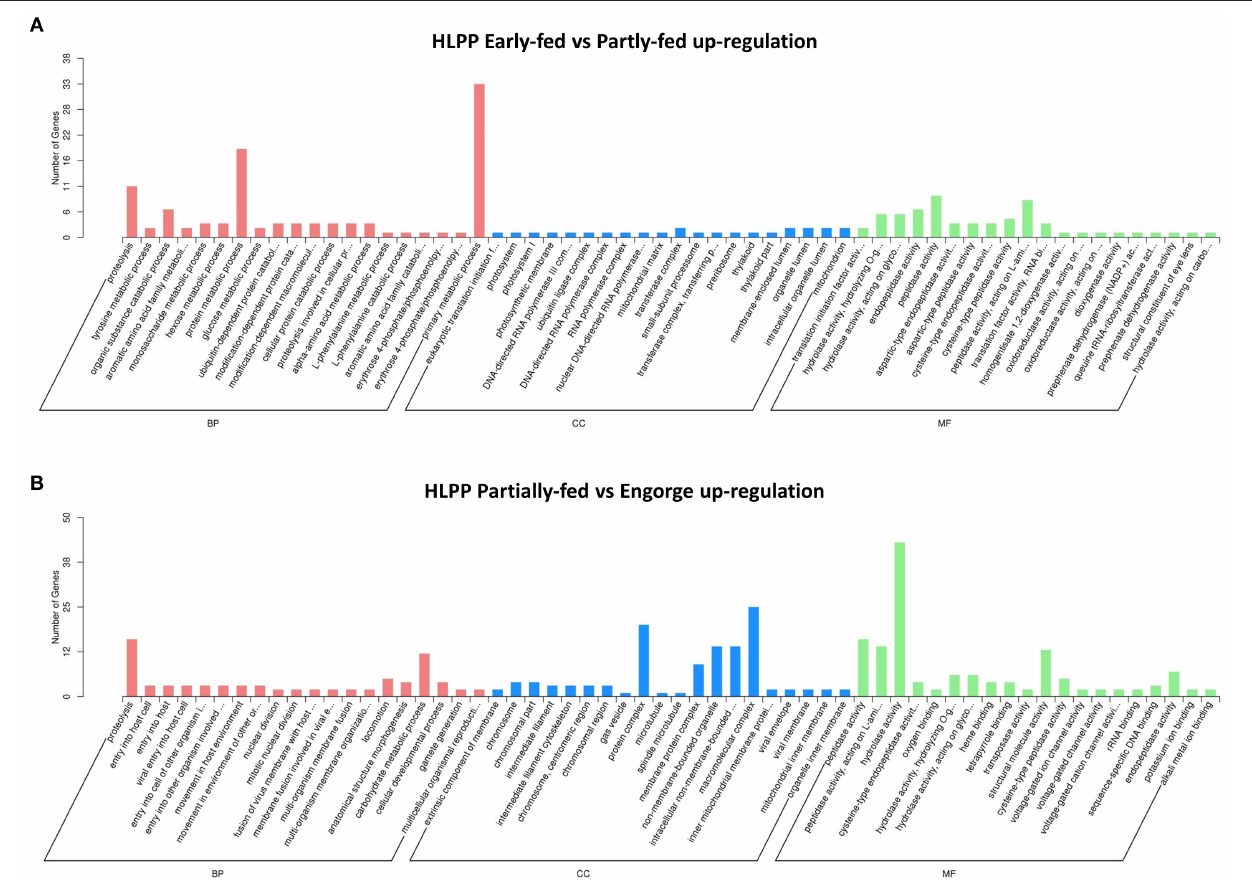
FIGURE 4 | Gene Ontology (GO) annotation enrichment of upregulation proteins in parthenogenetic H. longicornis (HLPP) at different feeding stages. The x-axis shows the functional categories of the proteins, and the y-axis shows the number of increased proteins. (A ) Comparison of parthenogenetic H. longicornis (HLBP) in early-fed to partially-fed stages. (B) Comparison of parthenogenetic H. longicornis (HLBP) in partially-fed to engorge